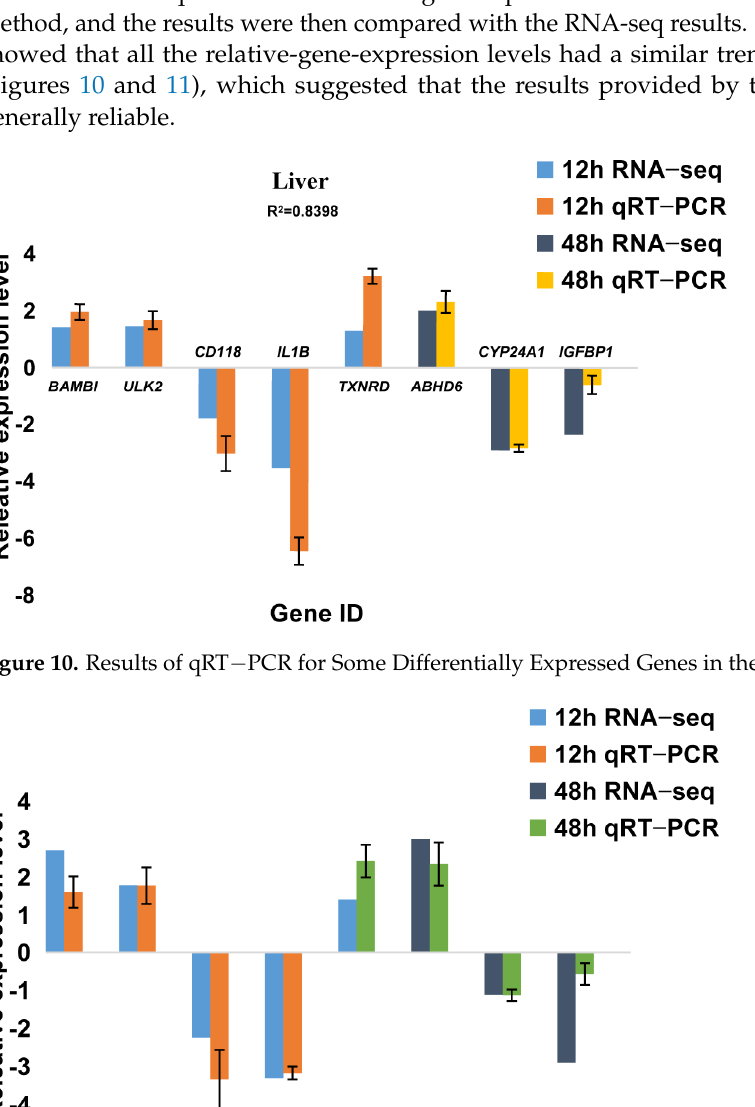
Figure 9. The Top 20 KEGG Pathways Enriched by the Differentially Expressed Genes of the Shared Genes Between the Liver and Spleen at 48 h Postinjection, and the Network Graph among these work Graph among these Pathways.